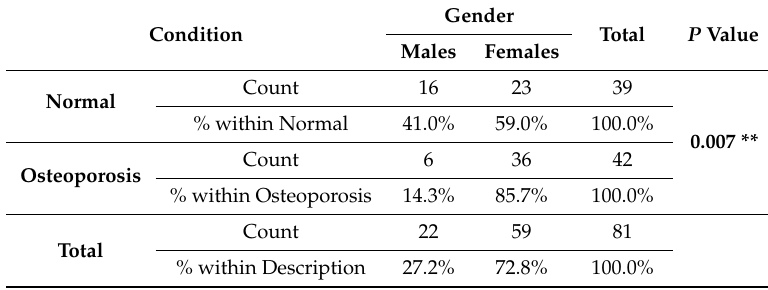
Table 1. Comparative evaluation ( χ 2 : 95% CI) of gender among the study groups, illustrating a significant association of female gender with osteoporosis.